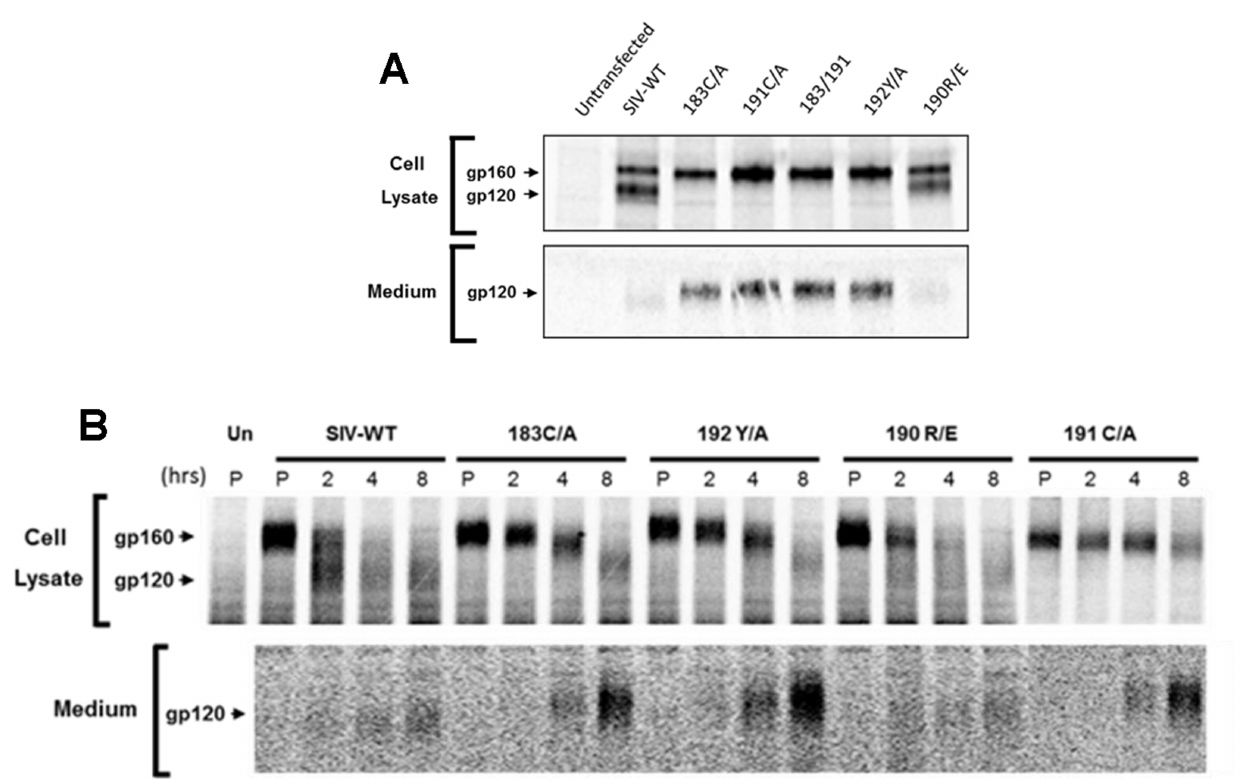
Figure 5. Expression, processing and subunit association of SIVmac239 variants. Cells expressing the SIVmac239 Env variants were labeled with 35 S-(methioine and cysteine) either continuously overnight ( A ) or in a pulse-chase experiment ( B ). The cells were pulsed in 35 S-labeling medium for 60 min (P), and then chased for 2, 4 and 8 hours. Un=untransfected cells.